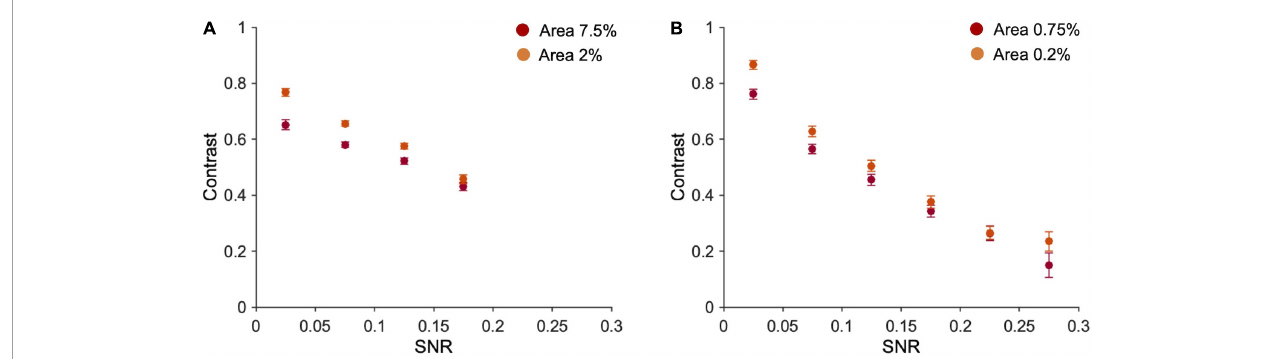
FIGURE5 Fragments’ contrast vs. their SNR. (A) Average contrast of ten fragments vs. their average SNR (bins of 0.05 each). Number of occurrences in each bin (from the first to the last bin), 7.5% area: 345, 1,380,783,491; 2% area: 497,1202,857,444. (B) Average contrast vs. averaged SNR of one fragment (bins of 0.05 each). Error bars are standard errors. Number of occurrences in each bin (from the first to the last bin) = 0.75% area: 834,873,586,425,235,47; 2% area: 748,764,620,440,